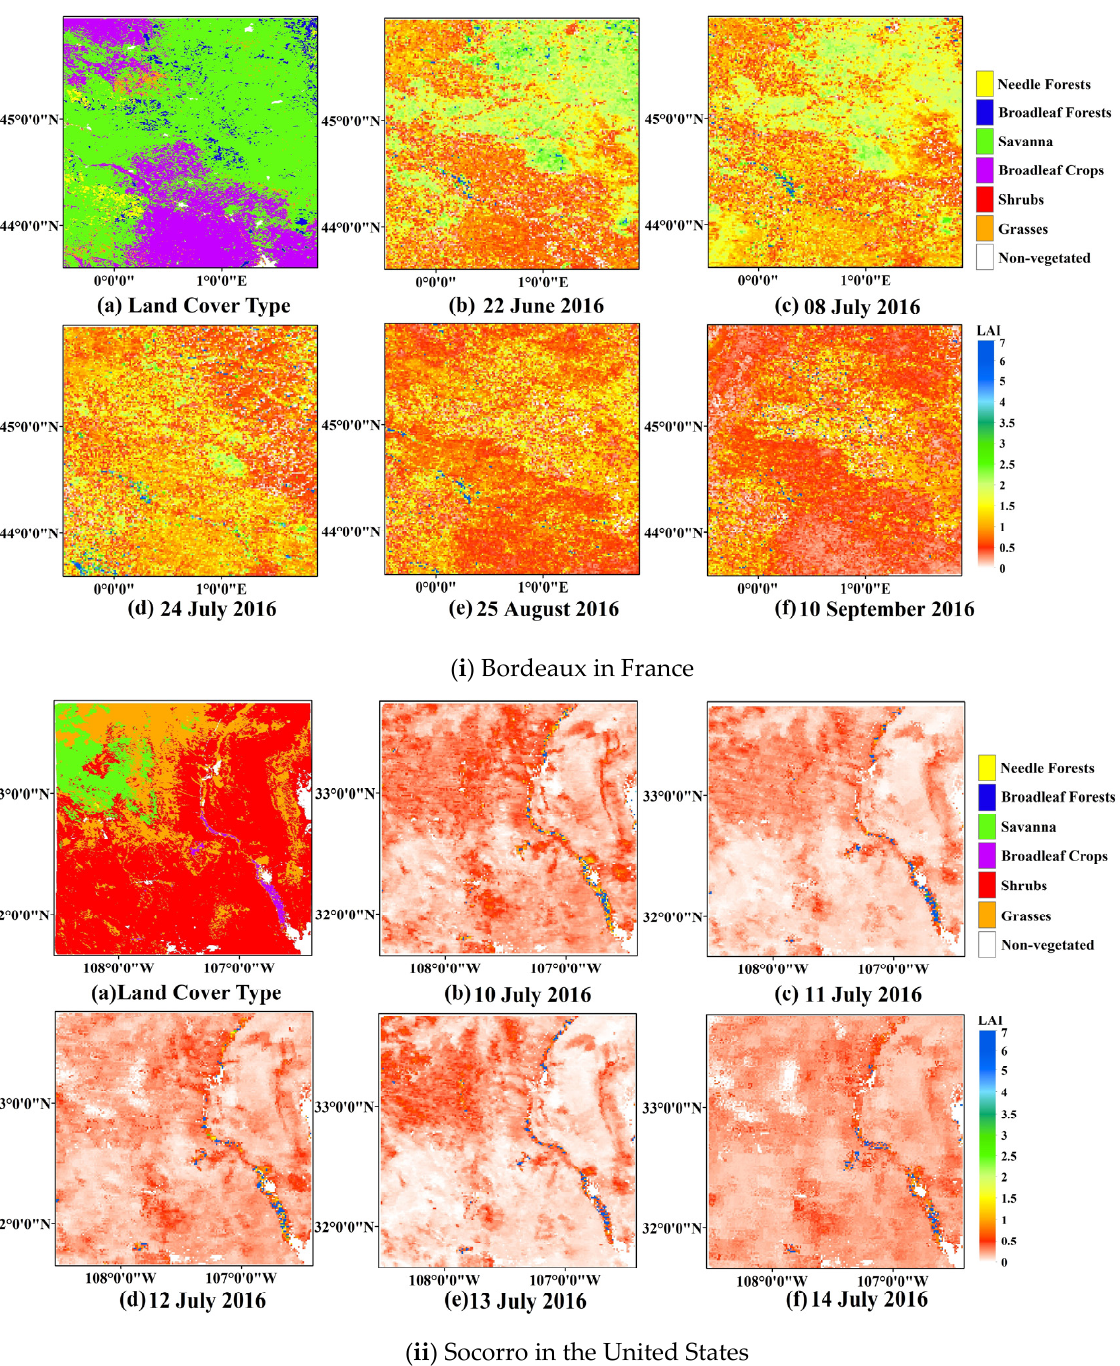
Figure 7. LAI dynamic change maps. Panel ( a ) represents the land cover type, panels ( b – f ) represent the LAI maps of the different Julian days.